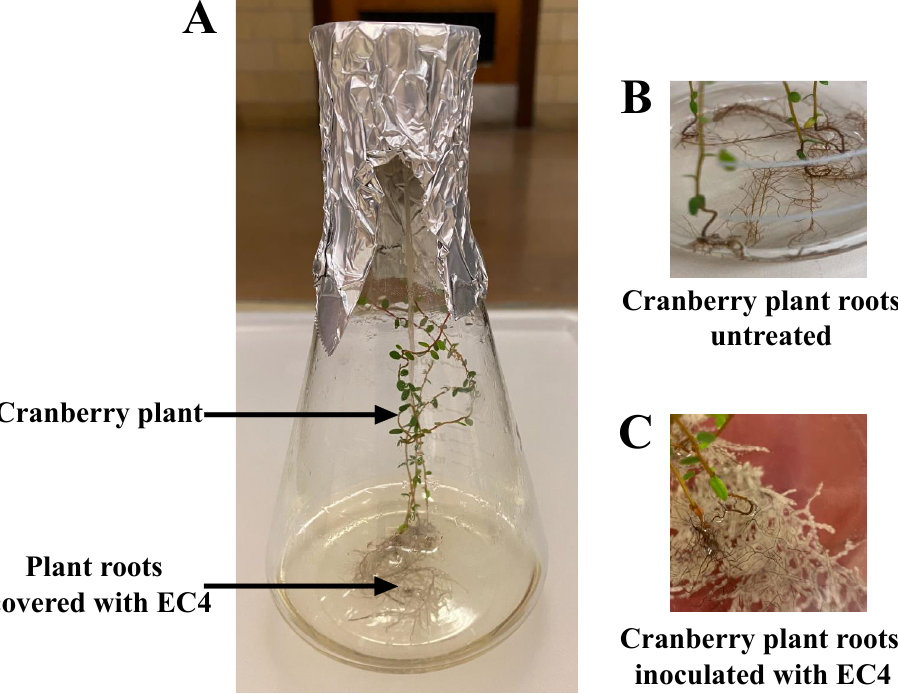
Figure 1. Cranberry plant inoculated with EC4 and cultivated in liquid medium. Microbe-free cranberry plantlets were first grown in a minimum mineral medium for three months, then transferred to a yeast-glycerol medium inoculated with EC4. ( A ) Experimental set-up. ( B ) Roots of control plant in medium without EC4. ( C ) Mycelium-covered plant roots in EC4-inoculated medium.